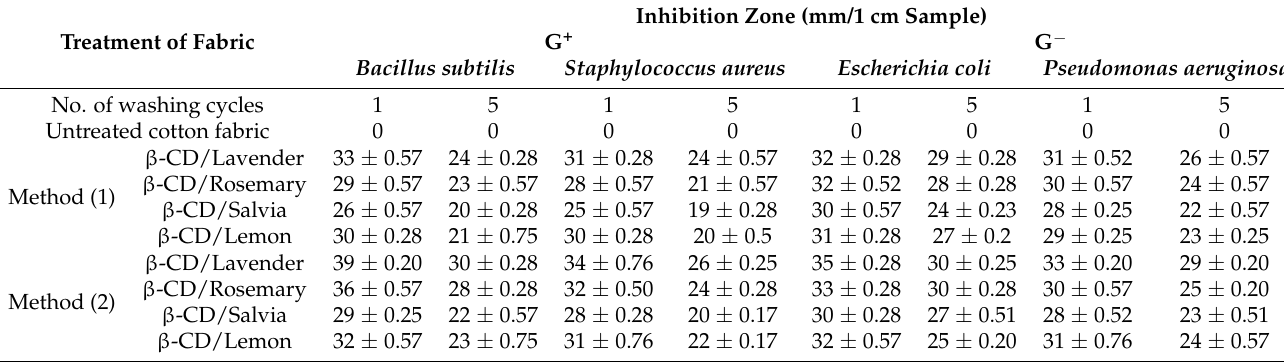
Table 1. Antibacterial activity and durability properties for different fabrics’ treatments against different bacterial